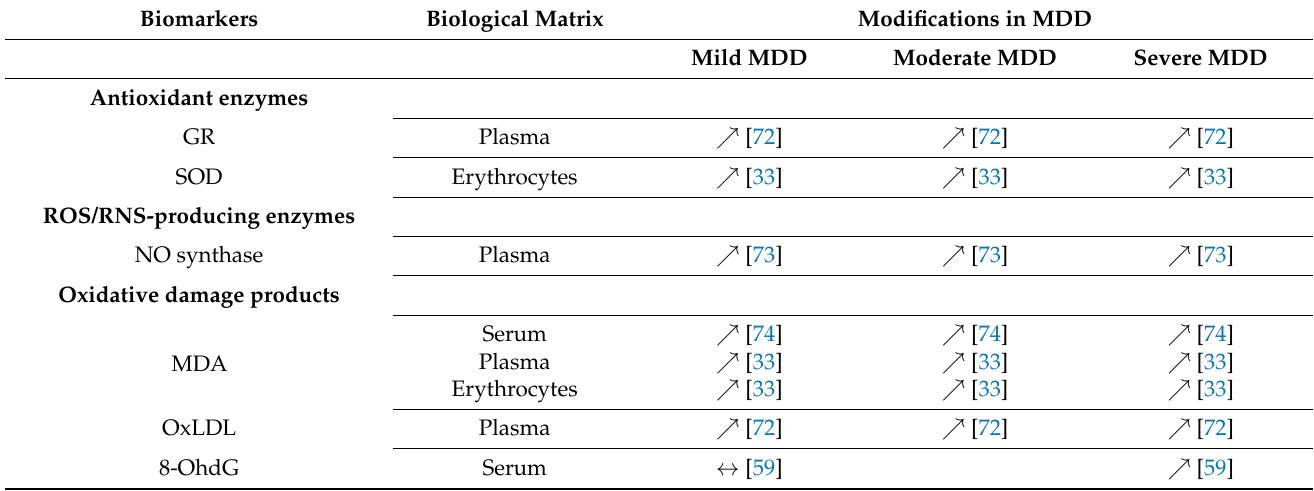
Table 6. Peripheral biomarkers of oxidative stress according to severity of MDD patients com- pared to healthy controls. MDD: Major depressive disorder—GR: Glutathion Reductase—SOD: Superoxide dismutase (information about isoform was not provided)—MDA: Malondialdehyde— oxLDL: Oxide LDL—8-OhdG: 8-hydroxy-2 (cid:48) -deoxyguanosine— (cid:37) : Values significantly higher in depressed patients compared to controls— (cid:38) : Values significantly lower in depressed patients compared to controls— ↔ : No significant difference between depressed patients and